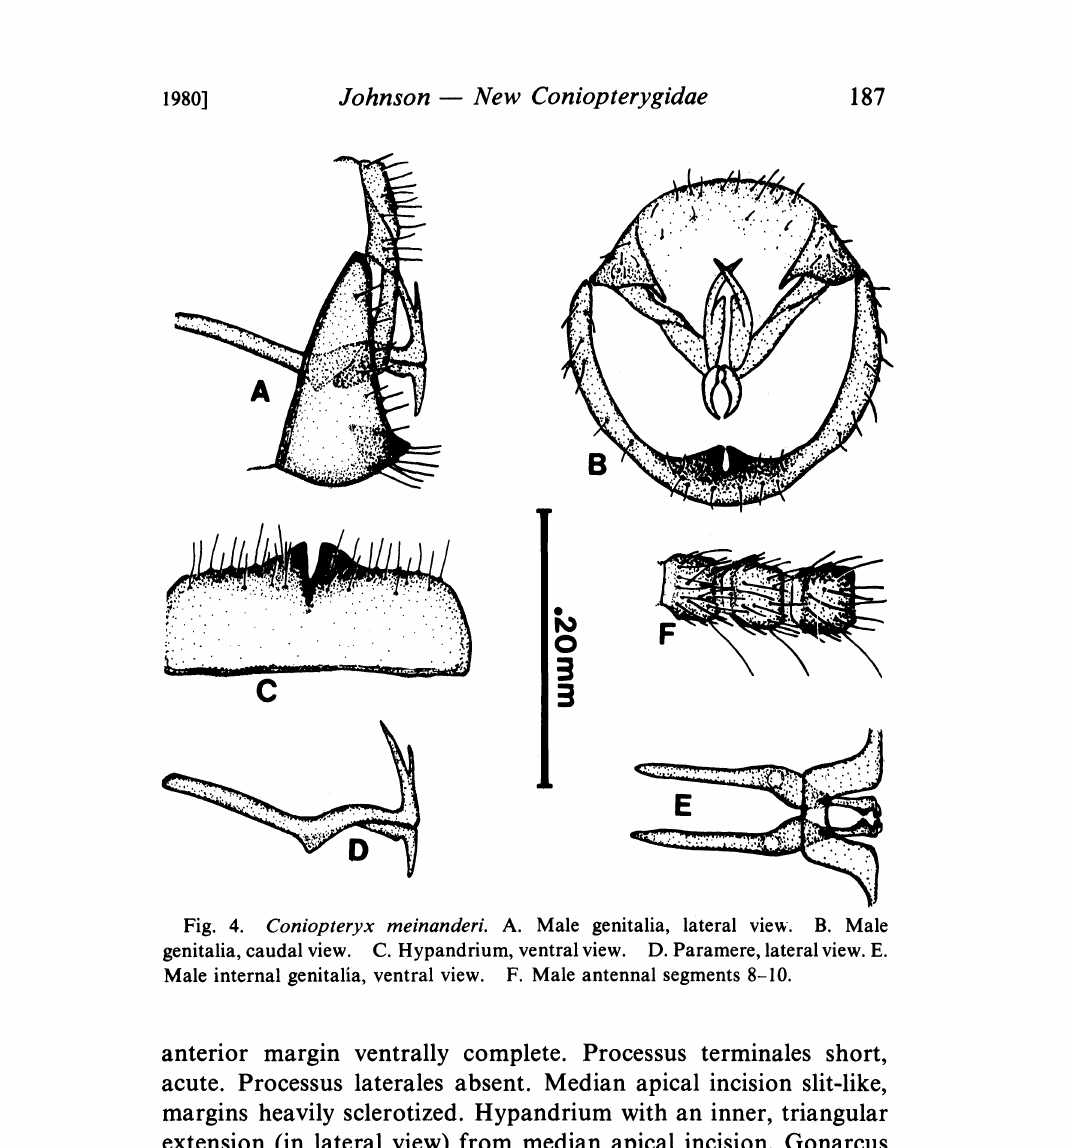
anterior margin ventrally complete. Processus terminales short, acute. Processus laterales absent. Median apical incision slit-like, margins heavily sclerotized. Hypandrium with an inner, triangular extension (in lateral view) from median apical incision. Gonarcus small, terminating in a tooth. Styli originating about midway on gonarcus, band-like, forming an arch below parameres. Parameres elbowed at processus ventrales. Processus apicalis bifurcate, inner branch short, straight; outer branch longer, curved medially. Penis consisting of two rods, apical halves of which are curved downward at almost right angle. In caudal view, penis looks